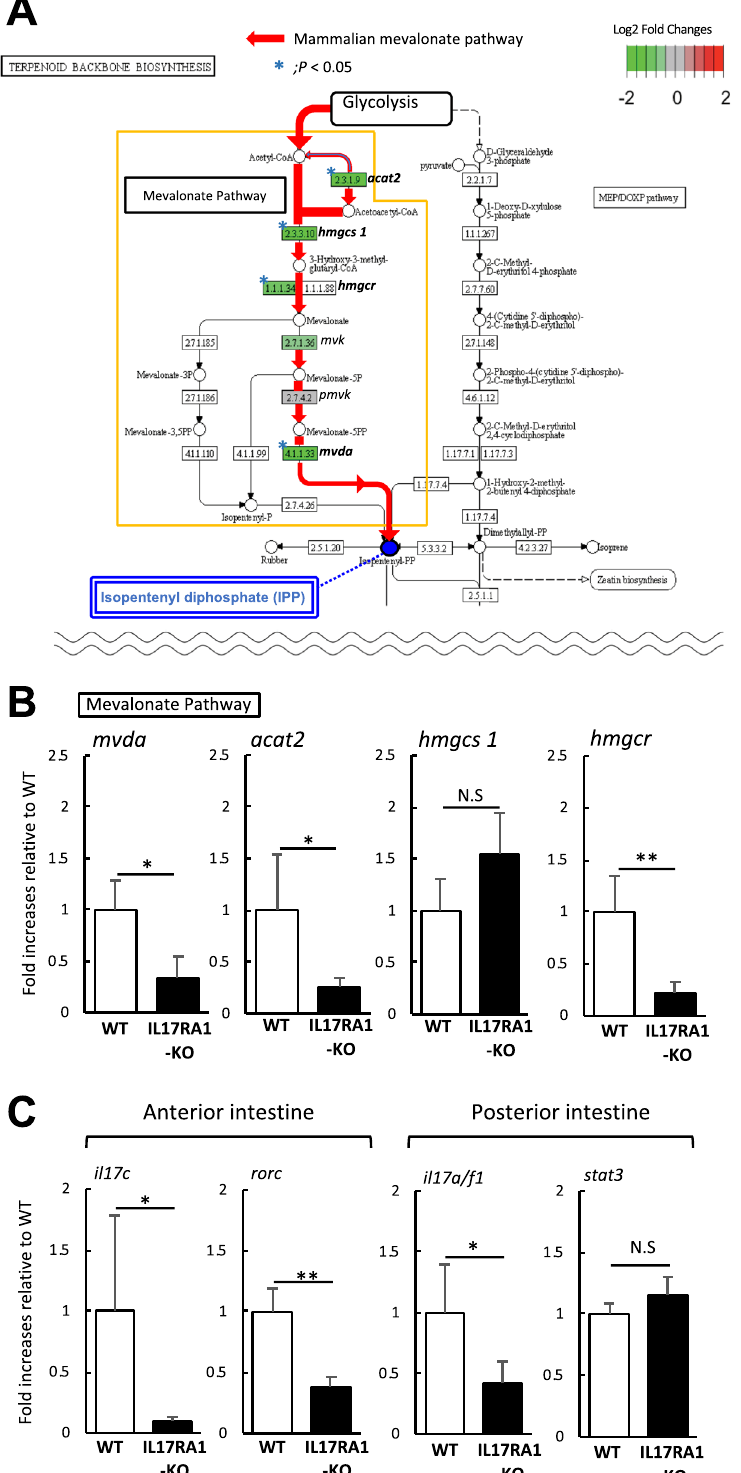
Figure 10. The reduction of the mevalonate pathway-related genes in IL-17RA1-KO medaka intestines. ( A , B ) In the anterior intestine of IL-17RA1-KO medaka; four of six enzyme-encoding genes participating in the mevalonate pathway described in KEGG map “Terpenoid backbone biosynthesis” (KEGG map00900) were significantly down-regulated as shown by RNA-seq analyses ( A ). Of these four genes, the reduction of acat2 and hmgcs1 was confirmed by qPCR. ( C ) qPCR analysis was also used to confirm the reduced expression of IL-17 signaling-related genes, il17c and rorc , observed by RNA-seq. ** P < 0.01, * P < 0.05 (Student’s t -test or Welch t -test in R version 3.5.3). The data shown were obtained in one experiment with five individual fish (n =